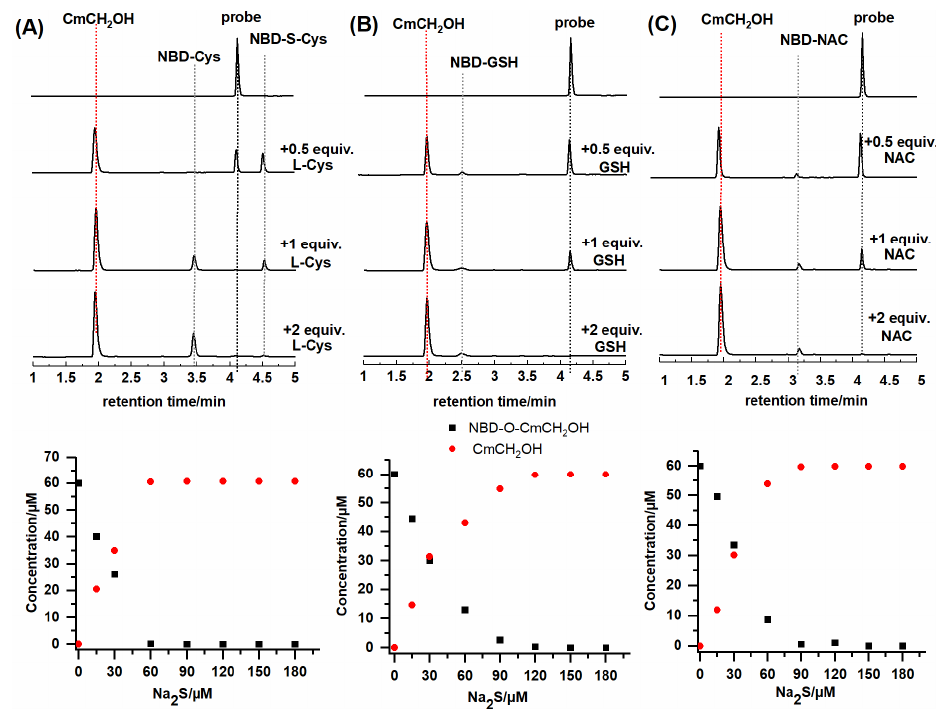
Figure 7. HPLC chromatogram and the HPLC based-titration of the reaction mixtures of NBD-O- CmCH 2 OH (60 μ M) with ( A ) L-Cys (0–180 μ M), ( B ) GSH (0–180 μ M), ( C ) NAC (0–180 μ M) after 15 min incubation. The traces were collected using an absorption detector set at 330 nm.